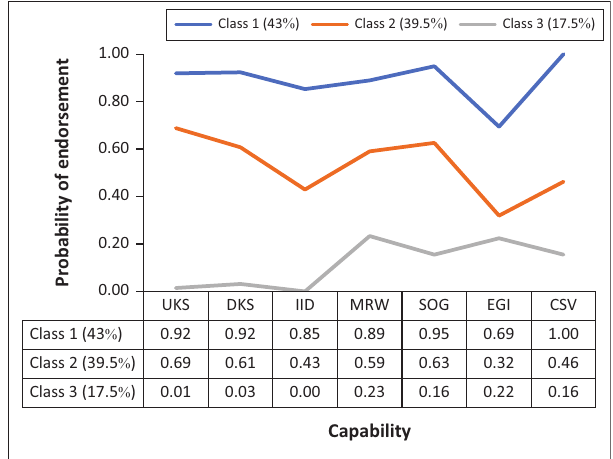
FIGURE 1: Latent classes of capability